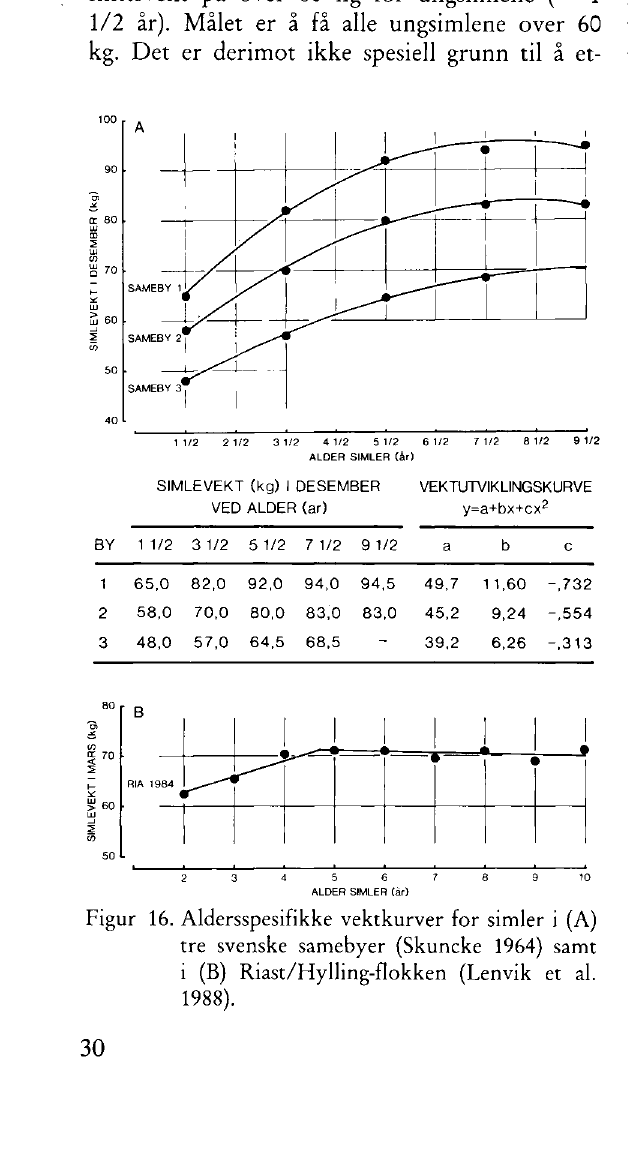
Figur 16. Aldersspesifikke vektkurver for simler i (A) tre svenske samebyer (Skuncke 1964) samt i (B) Riast/Hylling-flokken (Lenvik et al.